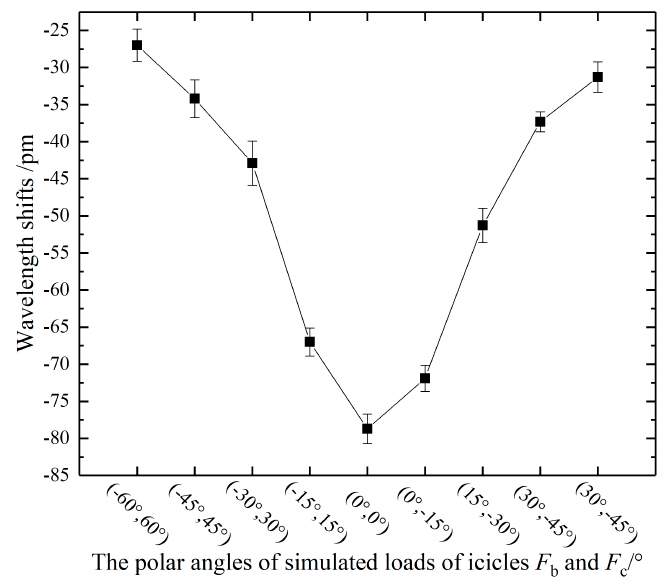
Figure 8. The relationship between the wavelength shift of FBG103 and the positions of simulated loads.